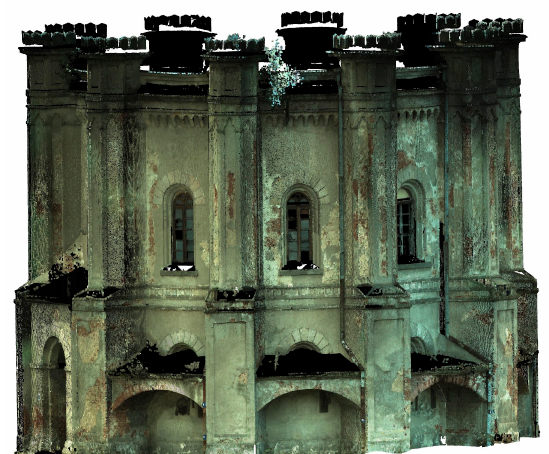
Figure 9. Visualization of the TLS point cloud.